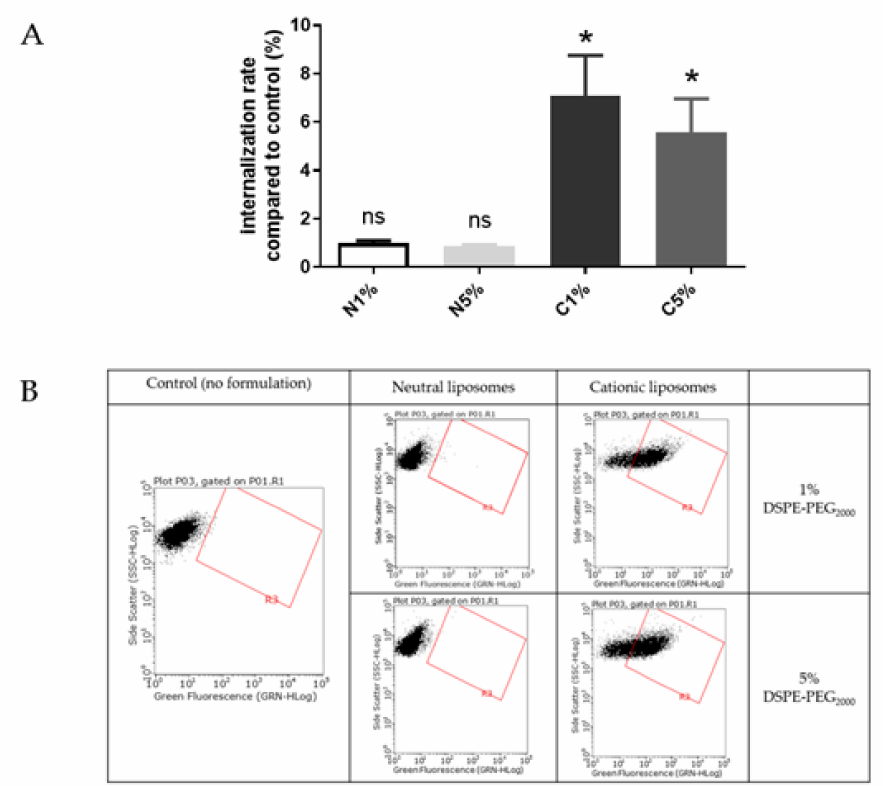
Figure 4. ( A ) Internalization into BeWo cells of neutral liposomes (0.15 mM) and cationic liposomes (0.03 mM) containing 1 % and 5 % PEG. Internalization rates correspond to fluorescence from flow cytometry experiments relative to the control (cells incubated with medium only); data represent the mean ± SEM (n = 3); * indicates a significant difference compared to the control ( p < 0.01, Mann- Whitney); ( B ) Flow cytometry dot plots for liposomes internalization evaluation (green fluorescence, DOPE-NBD) after incubation with fluorescent neutral or cationic liposomes (1 or 5 % PEG) at 0.15 mM and 0.03 mM respectively for 4 h. A minimum of 15,000 cells/samples were